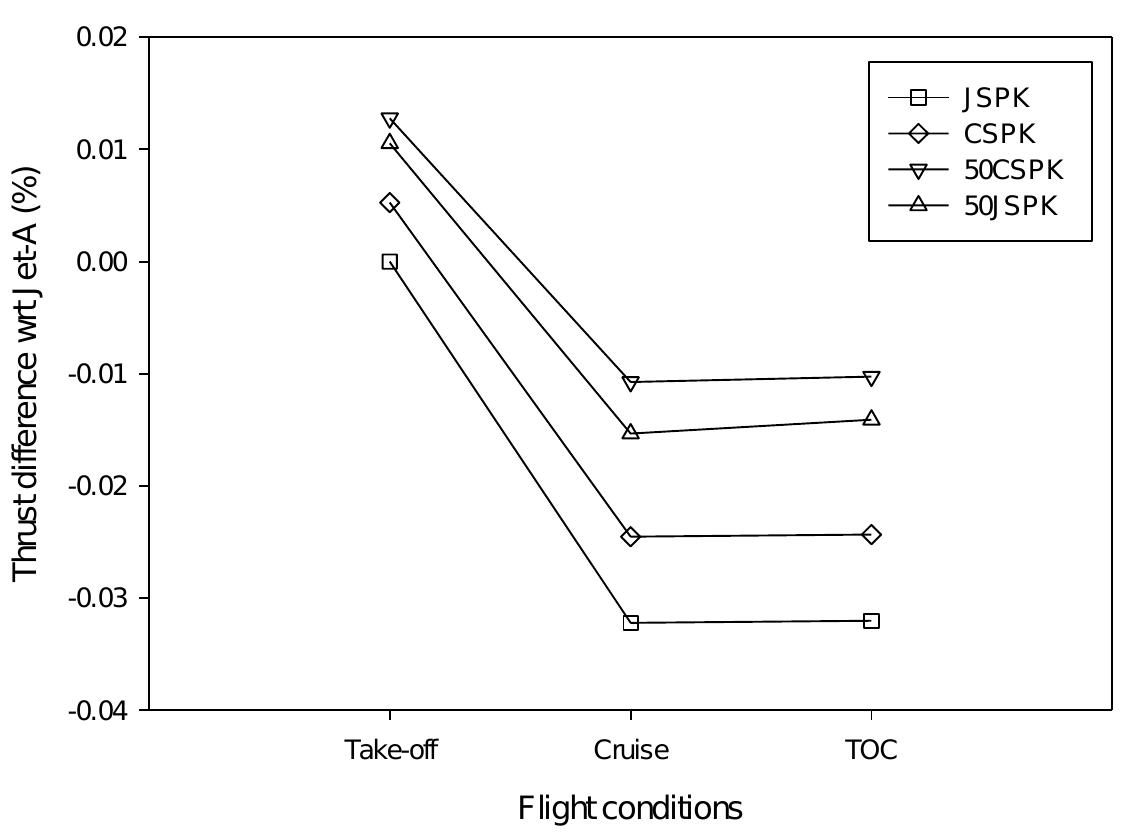
Figure 4. Thrust difference of biofuels compared to Jet–A. According to Mattingly [31], the total thrust ( F ) of a turbofan is a combination of thrust from the fan section ( F fan ) and thrust from the core engine ( F Core ) (Equation (2)). The thrust of each section (fan and core) was derived from the multiplication of the mass flow rate of each section with a difference between initial velocity ( V 0 ) and velocity at the fan nozzle ( V 19 ) and velocity at the core engine nozzle ( V 9 ) as shown in Equation (3) and Equation (4). The exit velocity of the core engine can be presented in terms of the ratio of the burner exit enthalpy to the ambient enthalpy ( τ λ ) , compressor temperature ratio ( τ c ) , total to static temperature ratio of the free stream ( τ r ) , and turbine temperature ratio ( τ t ) , as shown in Equation (5).